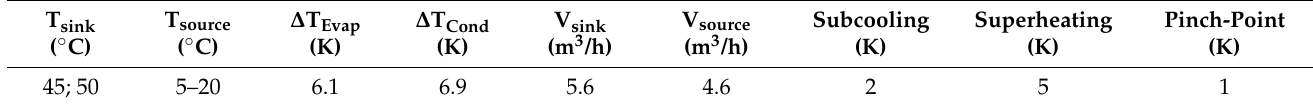
Table 2. Operating Table 2. Operating parameters.